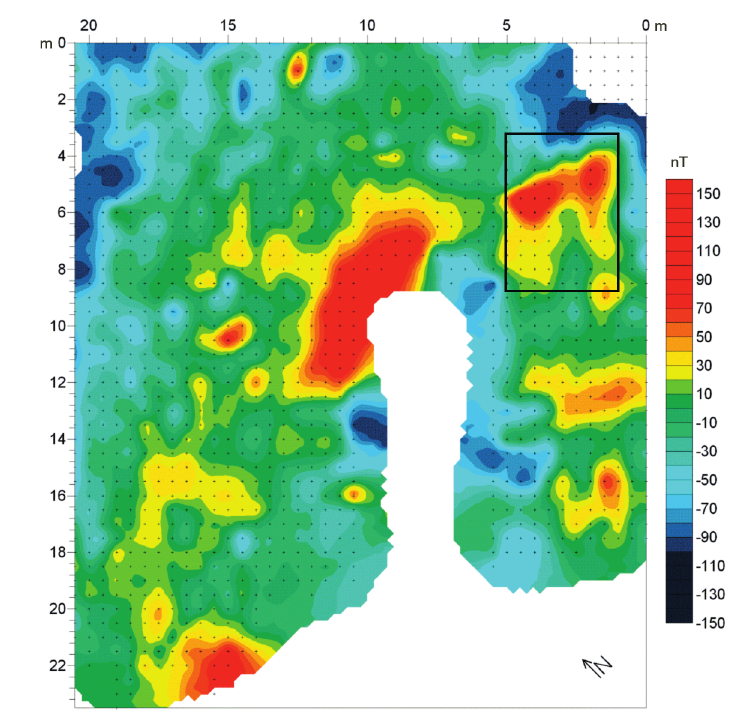
Fig. 10. Magnetic vertical gradient anomaly